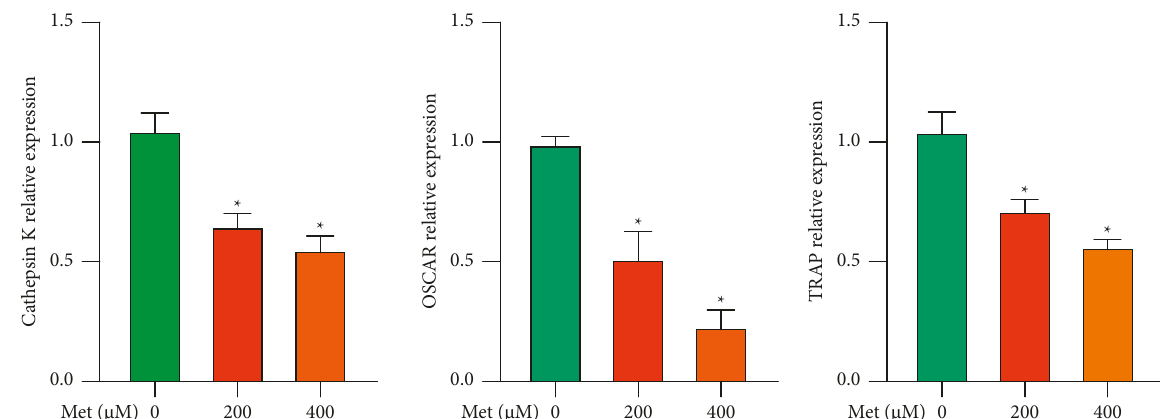
Figure 4: Met suppresses the expression of genes associated with osteoclastogenesis, such as Cathepsin K , OSCAR , and TRAP ( ∗ p < 0 . 05 ) . BMMs were induced and cultivated in media containing M-CSF (50 ng/mL), RANKL (100ng/mL), and 0, 200, or 400 μ M Met for 5d; then, the gene copies of Cathepsin K , OSCAR , and TRAP were quantified by real-time fluorescence quantitative PCR.